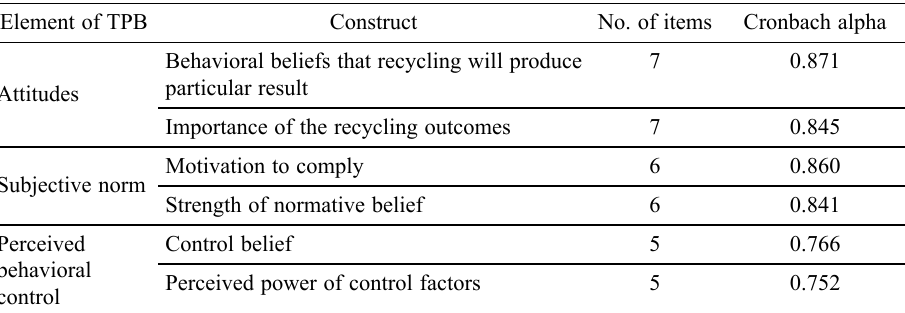
Table 3. Internal consistency of derivative